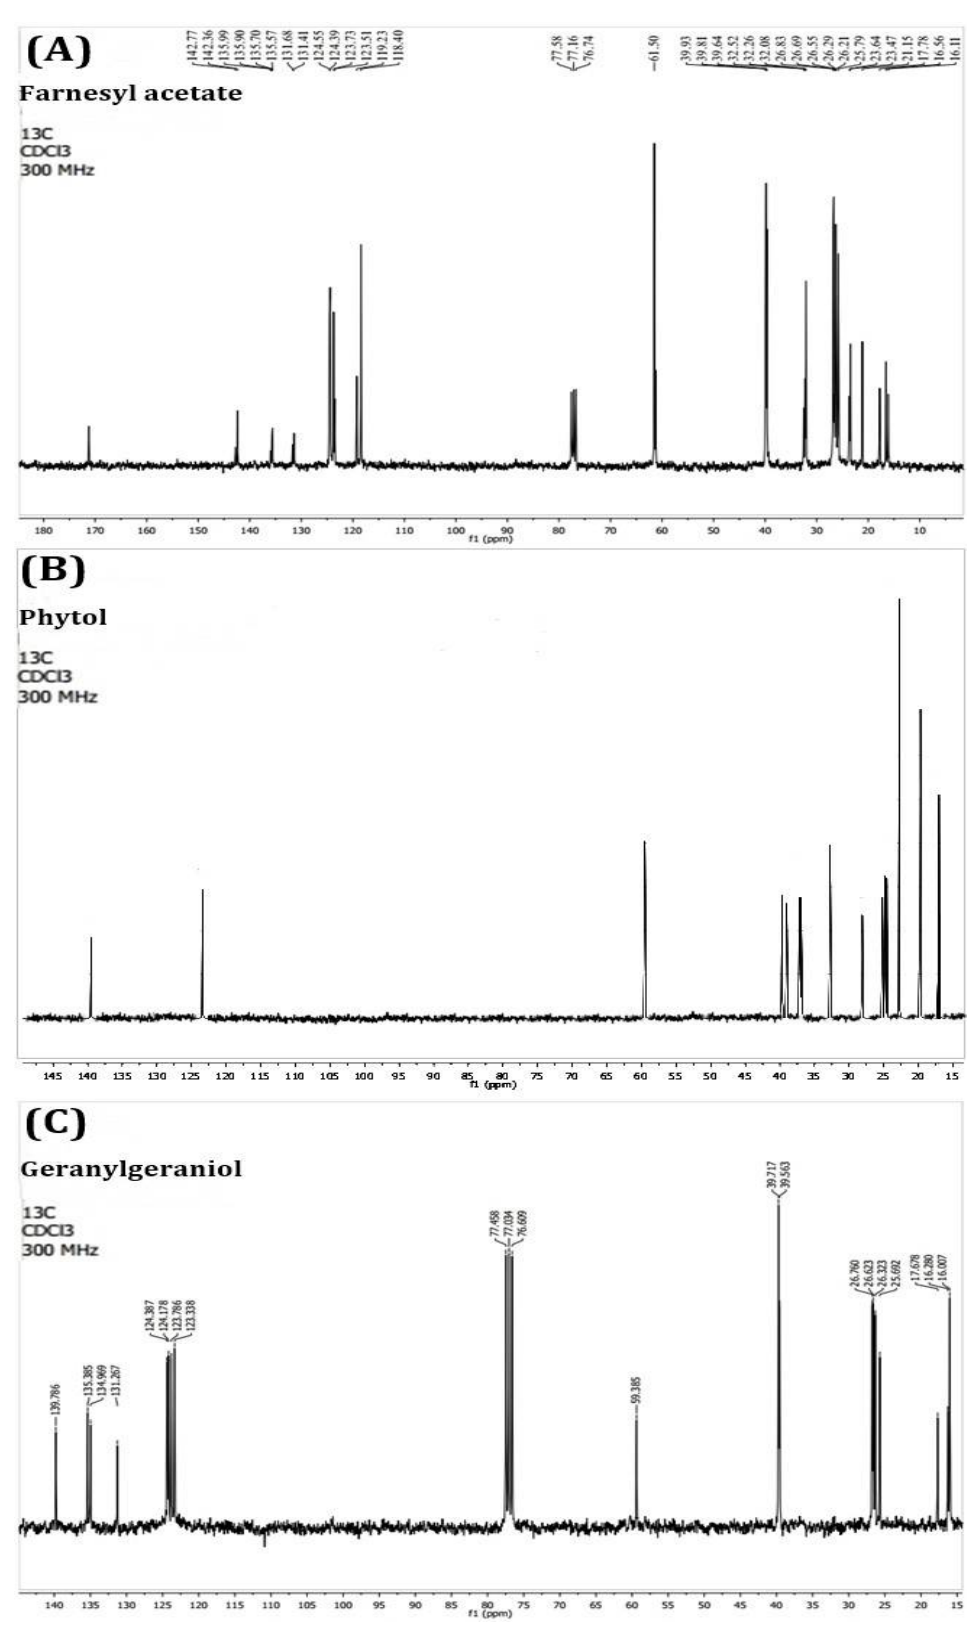
Figure 5. 13 C-NMR spectra of acyclic terpenoids farnesyl acetate ( A ), phytol ( B ) and geranylgeraniol ( C ).